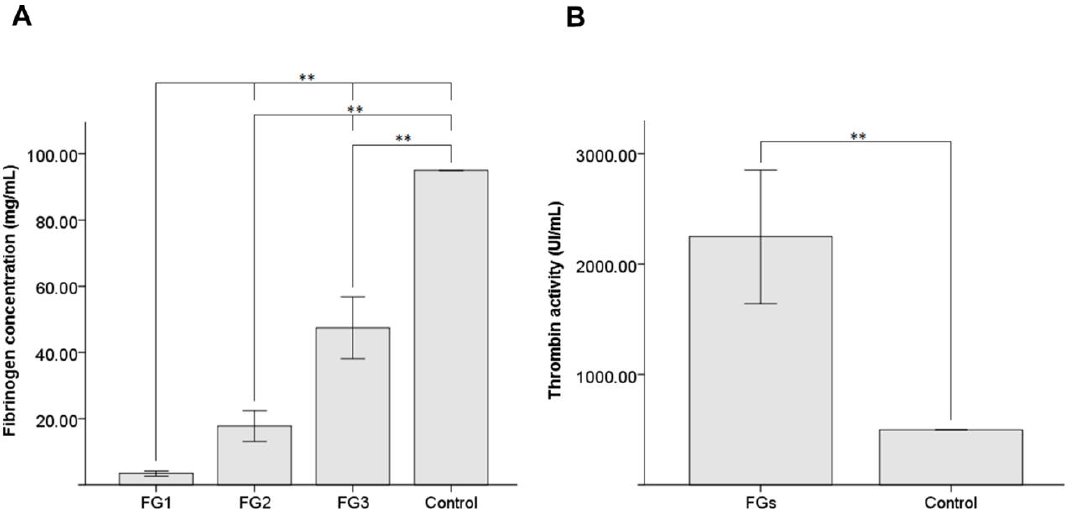
Figure 2. Mean fibrinogen concentration ( A ) and thrombin activity ( B ) obtained in FG1, FG2, and FG3, and a statistical comparison with the commercial FG as a control. **: p -value < 0.01. Data are shown as the mean ± SD. FG: bio-based fibrin glue.